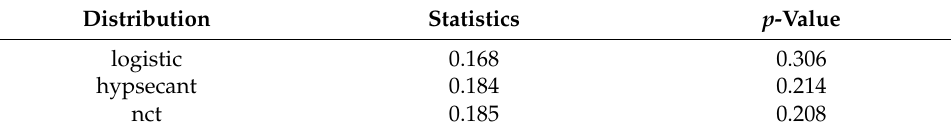
Table 2. Top three distributions to fit the NNDSS Dataset.